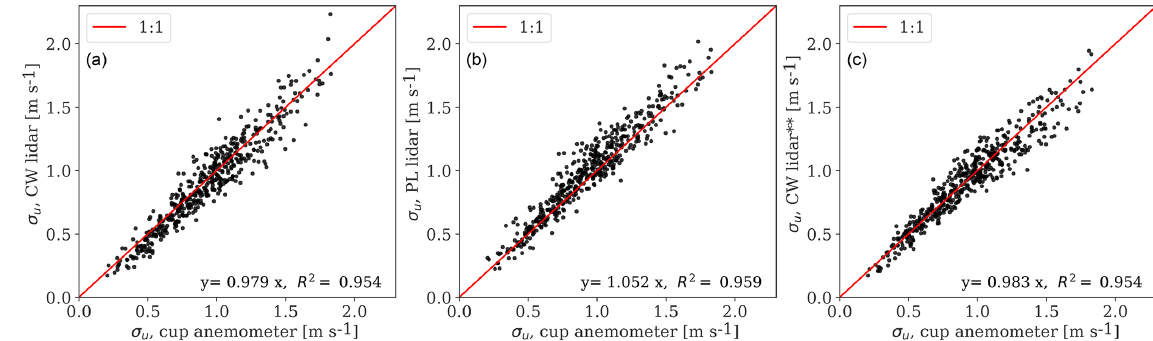
Figure 4. (a, b) Comparison of the lidar-based σ u , derived with the use of the spectral tensor model, with σ u values measured with an 80m cup anemometer mounted on the mast. (c) Comparison of lidar-based σ u , derived from the ensemble-averaged Doppler spectrum of the CW lidar, with σ u values measured with an 80m cup anemometer. We show a 1 : 1 line for guidance, the slope of a linear regression model, and the coefficient of determination R 2